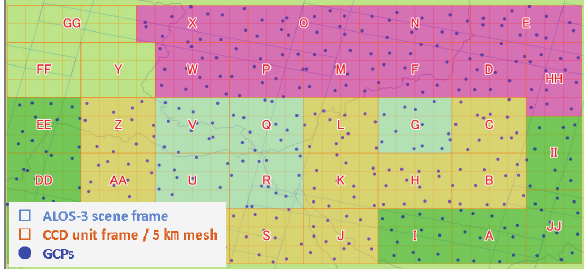
Figure 3. Dense GCPs network in Kanto district, Japan (approx.